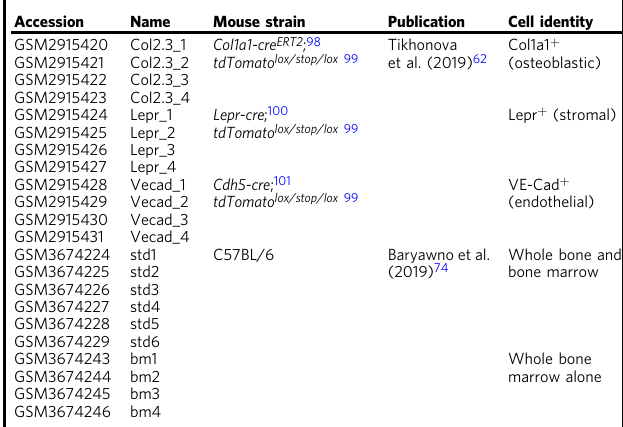
Table 2 Mice used for scRNA-seq of murine bone marrow cells in Tikhonova et al. 62 and Baryawno et al. 74